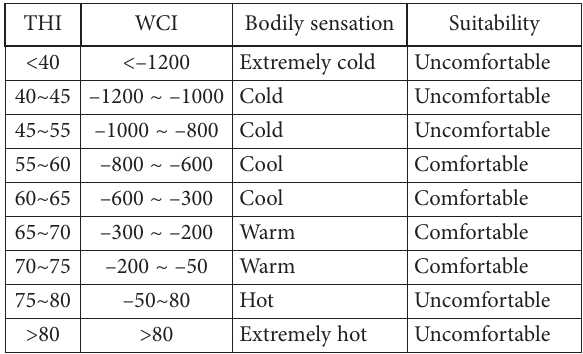
Table 2. Evaluation criteria for climate suitability indices THI and WCI (Tang et al.,